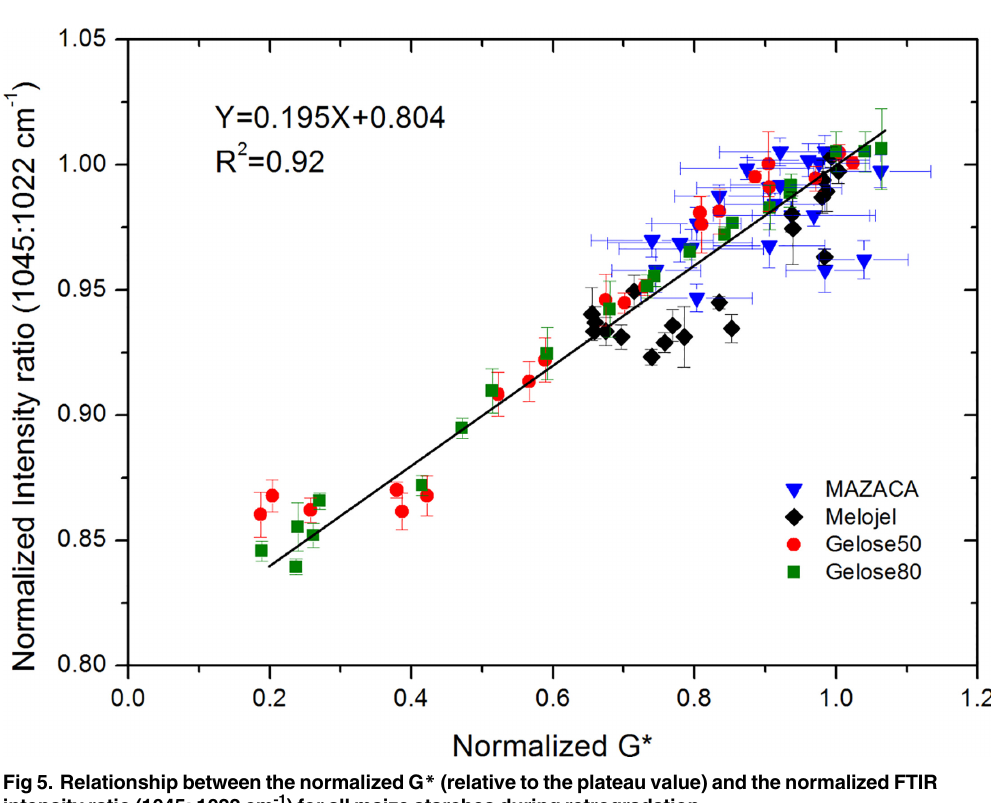
Fig 5. Relationship between the normalized G * (relative to the plateau value) and the normalized FTIR intensity ratio (1045: 1022 cm -1 ) for all maize starches during retrogradation.